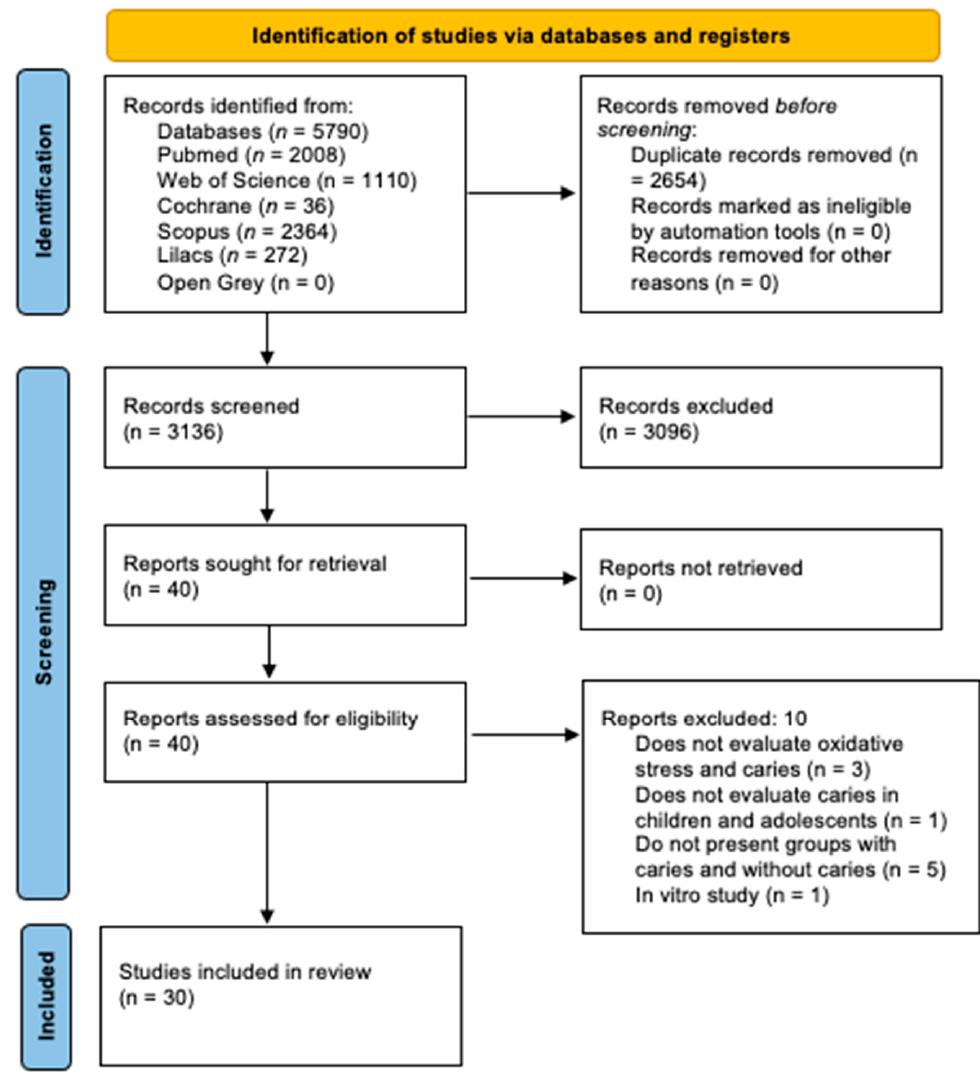
Figure 1. PRISMA 2020 flow diagram.